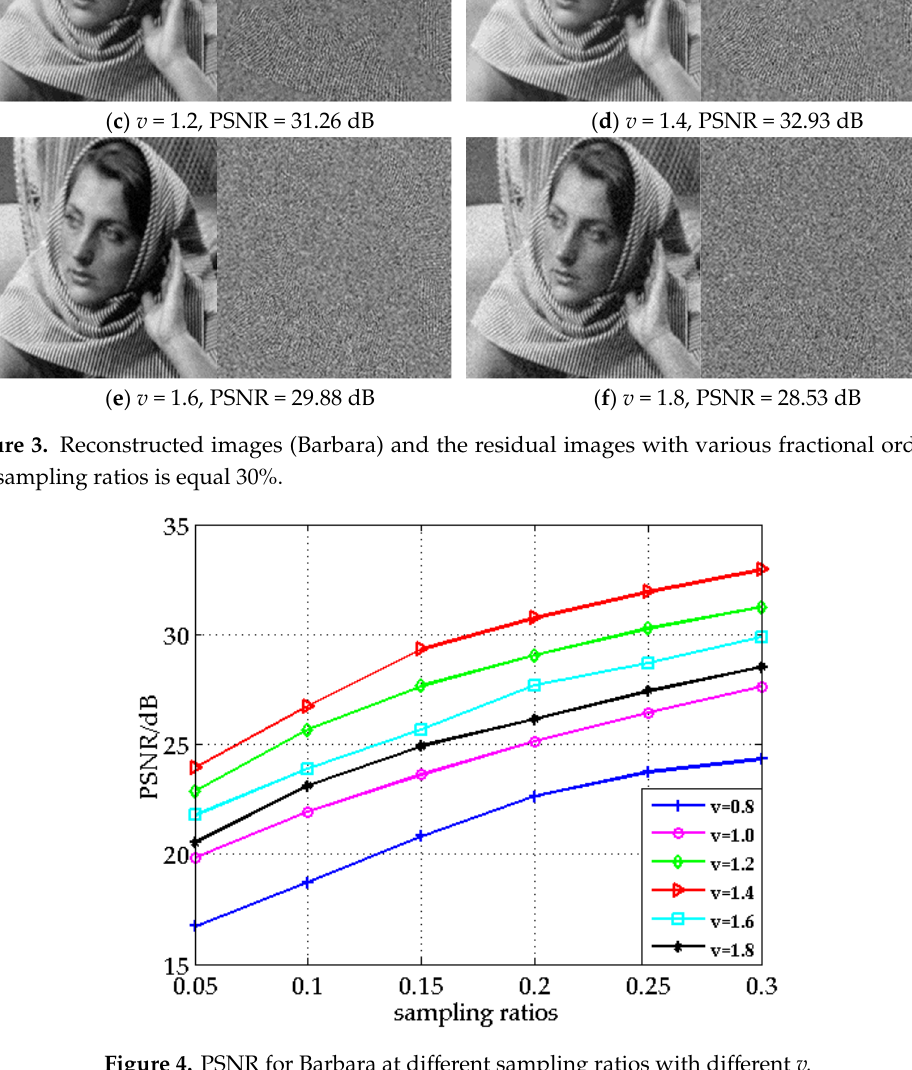
ff erent sampling ratios with di ff erent Figure 4. PSNR for Barbara at different sampling ratios with different v. Figure 4. PSNR for Barbara at di Figure 4. PSNR for Barbara at different sampling ratios with different v.